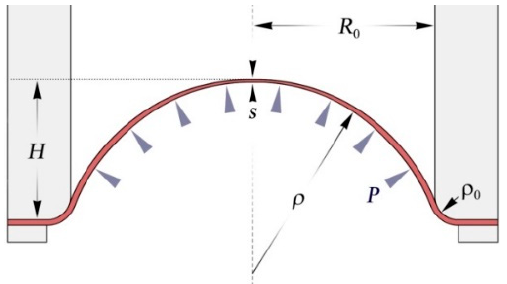
Figure 3. Scheme of free bulging test.